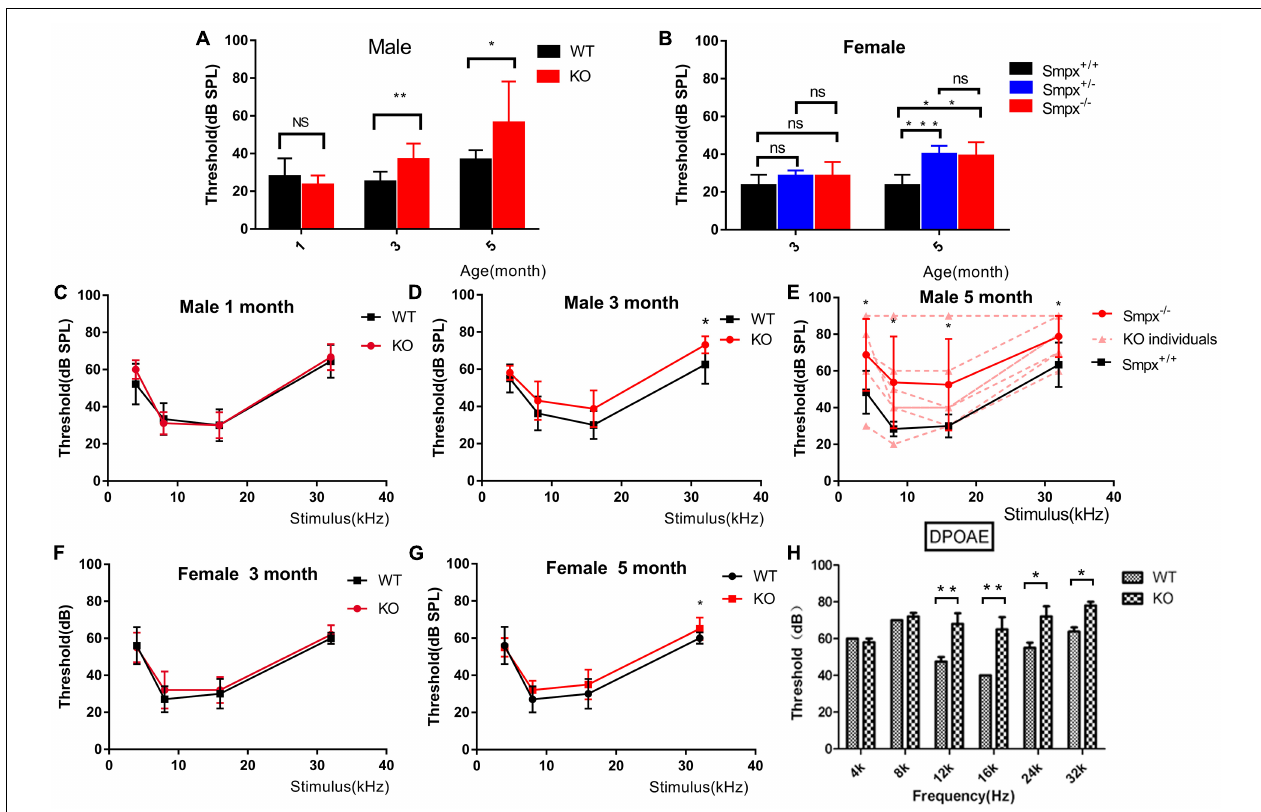
FIGURE 2 | Progressive hearing loss was displayed in ABR and DPOAE. (A) Broadband click stimuli induced ABR in male mice. Hearing loss started from the 3rd month and the hearing gradually decreased with aging. (B) Broadband click stimuli induced ABR of female mice. Hearing loss started from the fifth month, and homozygous and heterozygous mutation mice displayed similarities with aging. The hearing loss in female mice had a later onset and more mild than that in the males (C-E) . Frequency-specific pure tone induced ABR of male mice aged 1, 3, and 5 months. These ABRs indicated that hearing loss started at the 3rd month. The situation deteriorated from high to low frequency. In the 5th month, there was a 20 db threshold shift in 4 kHz pure tone. However, the individual difference was significant shown in panel (D) . Two-way ANOVA was used to compare the difference between two groups. * p < 0.05; ** p < 0.01; and *** p < 0.001. (F,G) Frequency-specific pure tone induced ABR in female mice at the 3rd and 5th month. Compared to male mice, the threshold shift occurred later and was milder. (H) DPOAE test on wild type and Smpx KO 3-month-old male mice. Threshold shift appeared from 12 to 32 kHz, which did not appear in low frequency at this time. This result was consistent with that in ABR (D)